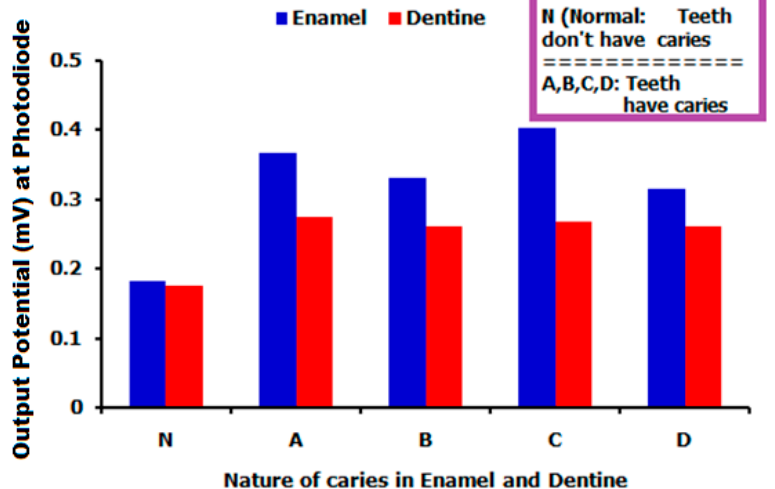
Figure 4. Output potential with respect to the enamel and dentine teeth.